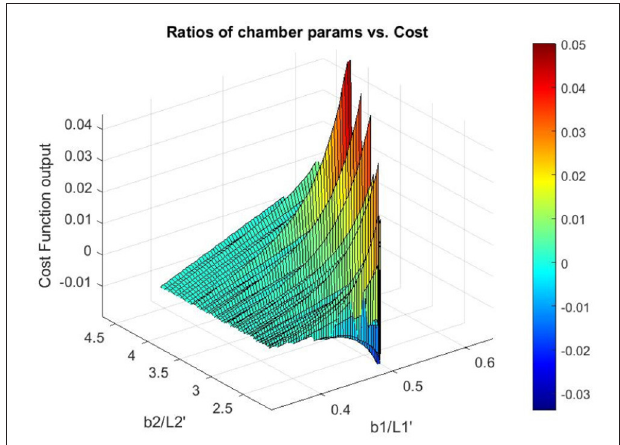
FIGURE 9 | Surface of cost function with parameter ratios for the outer cantilever from Figures 1E,G , and the central cantilever from Figure 1F .